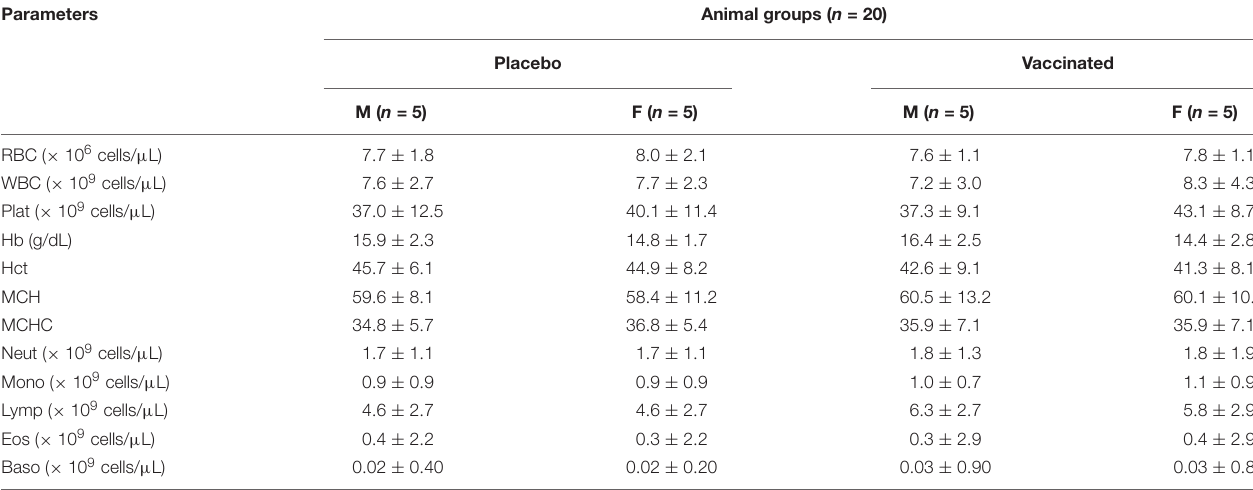
TABLE 1 | Average values (M ± SD) of hematological blood parameters of vaccinated hamsters after administration of the QazCovid-in vaccine candidate. Parameters